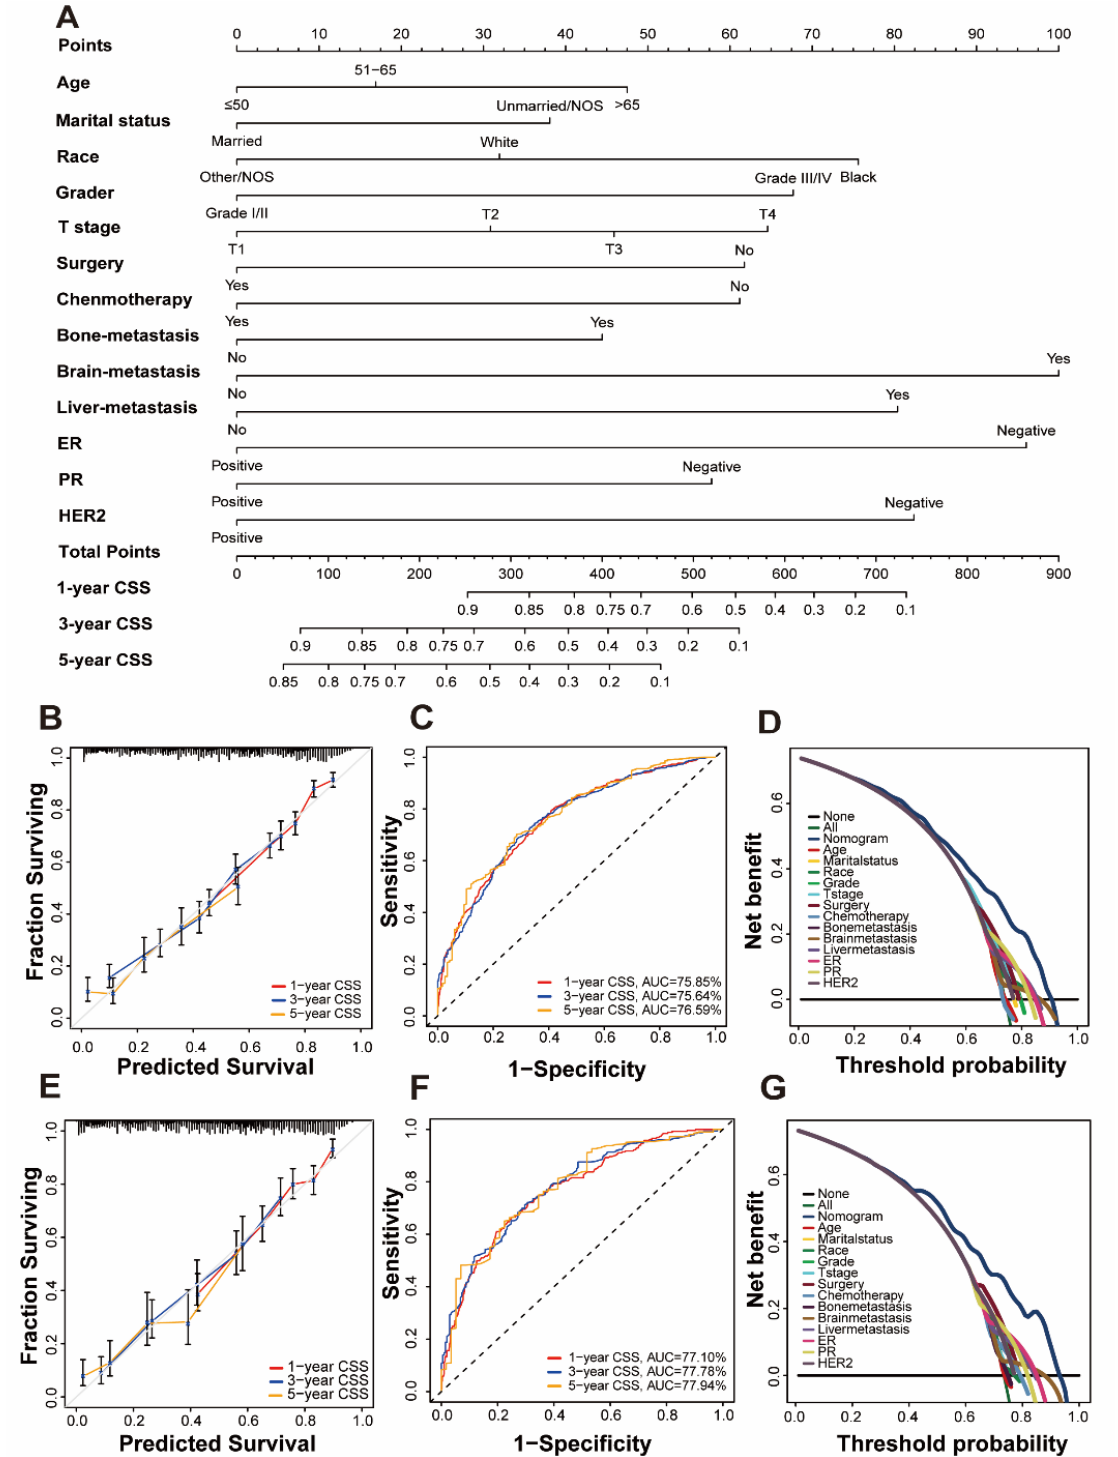
Figure 3. Nomogram and model assessment for predicting 1-, 3-, and 5-year cancer-specific survival (CSS) in BCLM patients. ( A ) The CSS nomogram for BCLM patients. The calibration plots in the ( B ) training and ( E ) validation cohorts for 1-year, 3-year, and 5-year CSS. AUC values of ROCs of the nomograms for 1-year, 3-year, and 5-year OS. The values in brackets B and E represent the area under the ROC curves (AUC). ( C ) for the training cohort and ( F ) for the validation cohort. Decision curve analyses (DCA) of the nomogram and other factors’ overall survival. ( D ) for the training cohort and ( G ) for the validation